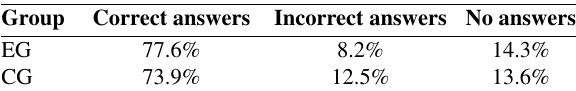
Table 5. Formation of propan-1-ol, percentages of correct and in- correct answers.